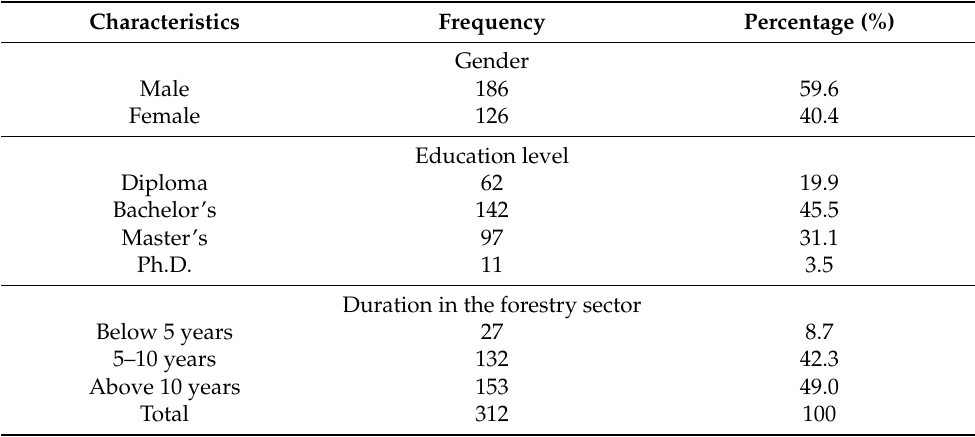
Table 3. Demographic data of study